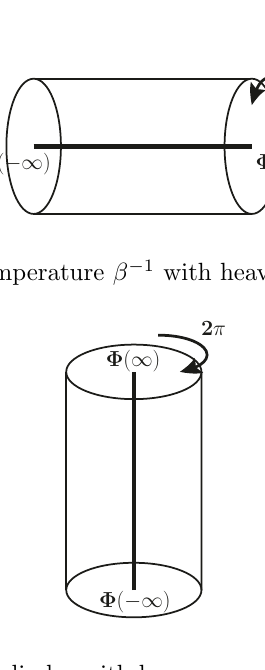
Figure 2 . CFT on a cylinder with heavy operators at temporal